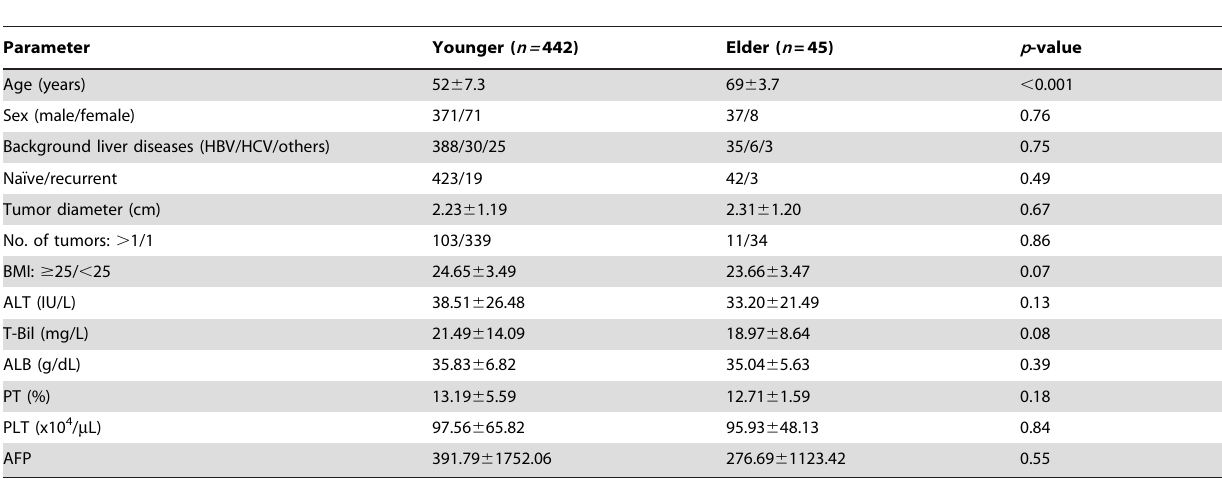
Table 1. Comparison of the demographic data of younger (Age # 65 y) and elder (Age . 65 y) HCC patients.